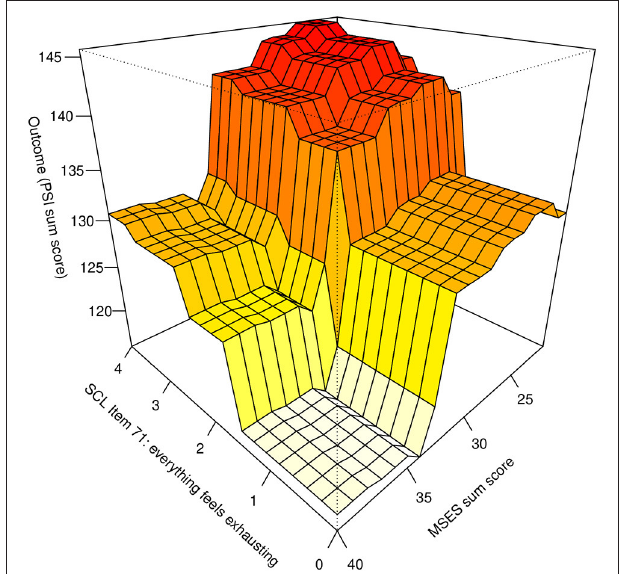
FIGURE 2 | Marginal effect of MSES sum score together with the SCL Item 71 on predicted PSI value. MSES, Maternal Self-Efficacy Scale; SCL, Symptom-Severity-Check-List-90R-S; PSI, Parenting Stress Index.